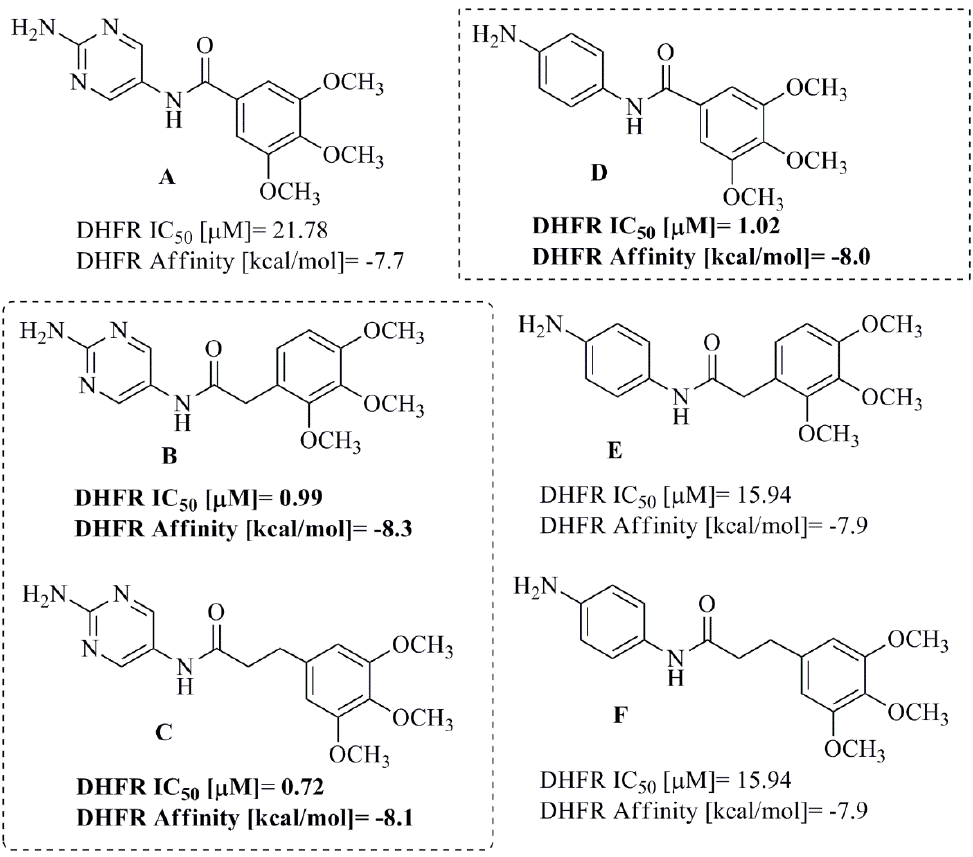
Figure 3. Structures of previously synthesized TMP analogs ( A – F